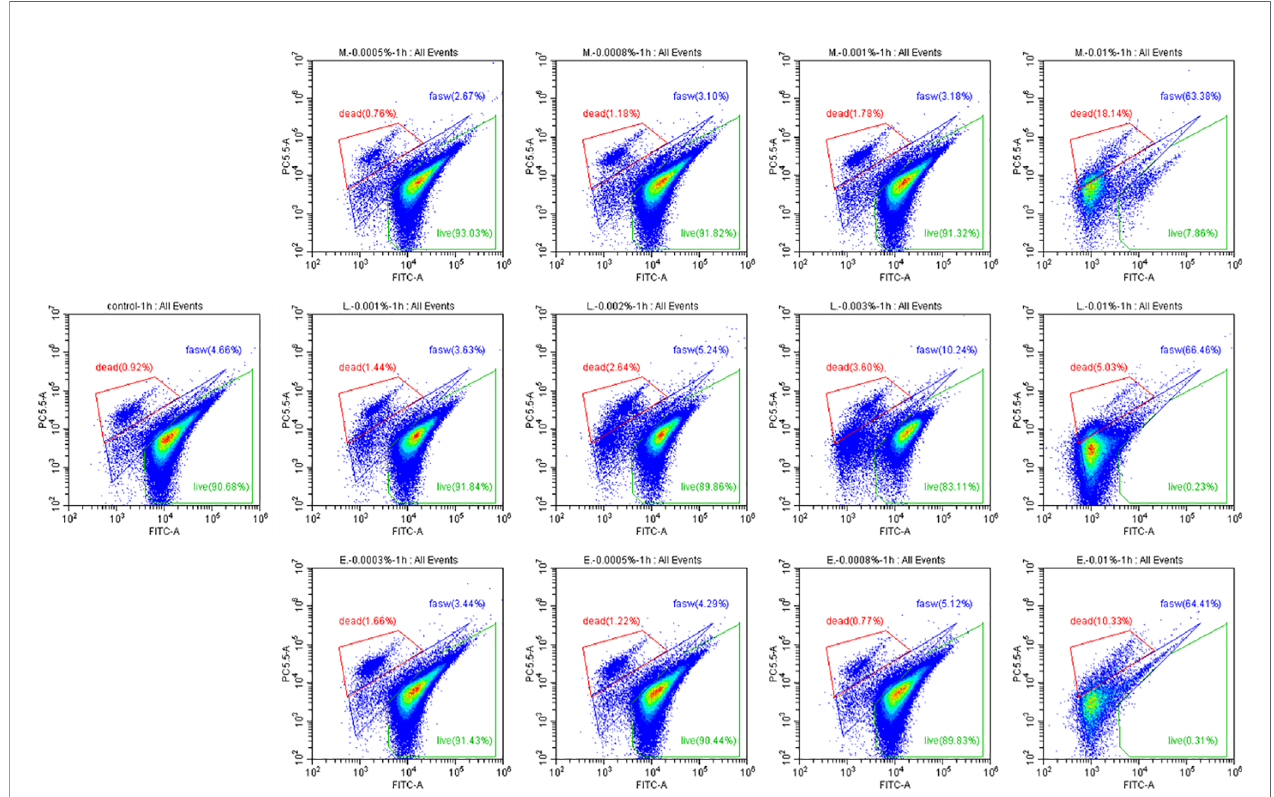
FIGURE 6 | Percentage of live and dead cells of Vibrio campbellii with or without the addition of essential oils. The fi rst line from left to right was the group of essential oil Melaleuca alternifolia at the concentrations of 0.0005, 0.0008, 0.001, and 0.01%; the second line from left to right was control group, the group of essential oil Litsea citrata at the concentrations of 0.001, 0.002, 0.003, and 0.01%; and the third line from left to right was the group of essential oil Eucalyptus citriodora at the concentrations of 0.0003, 0.0005, 0.0008, and 0.01%. Control: no EO added but consisted of 1% of DMSO. The plot of live cells was in the green frame, dead cells was in the red frame, and damage cells or other were in the blue frame.